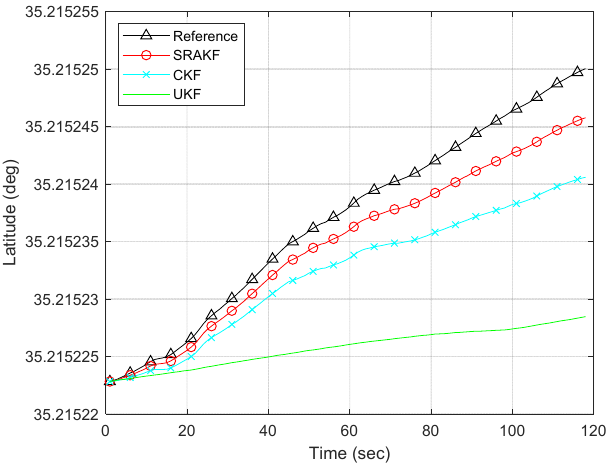
Figure 11. Latitude positions for the underwater lake trial.